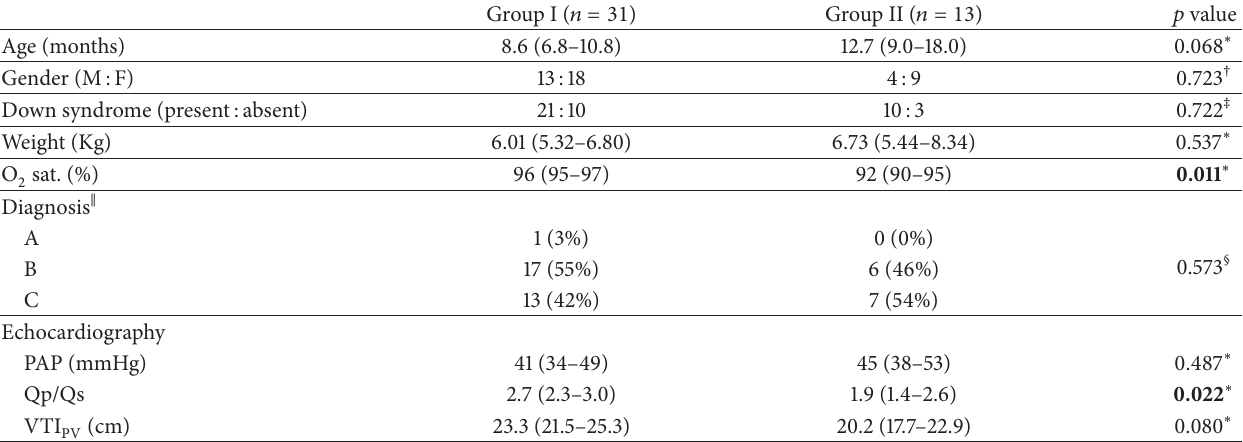
Table 1: Demographic and diagnostic data in patient